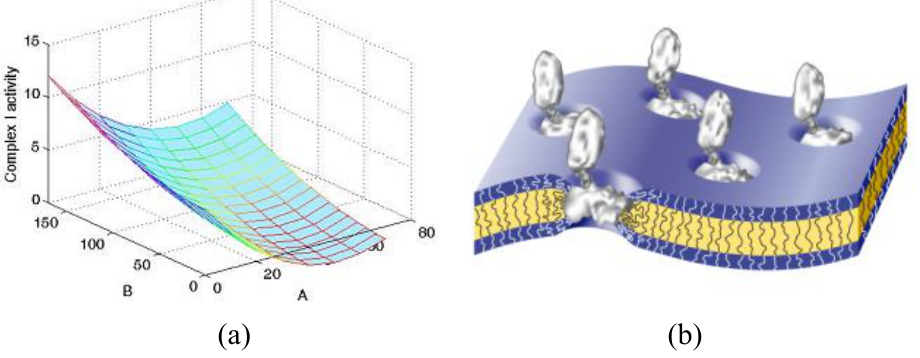
Figure 9. ( a ) Model for the activation ratio of complex I NADH: decyl-ubiquinone oxidoreductase activity as a function of the number of monomers in both hydrophobic and hydrophilic blocks (A and B). ( b ) Graphic representation of complex I incorporated in a copolymer